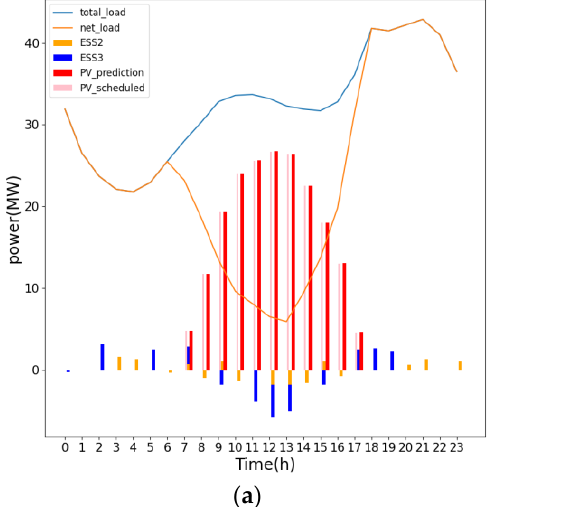
Figure 12. Case 1: result of third ED of ( a ) PV generation and the charge and discharge of ESS and ( b ) the power output of the diesel generators.